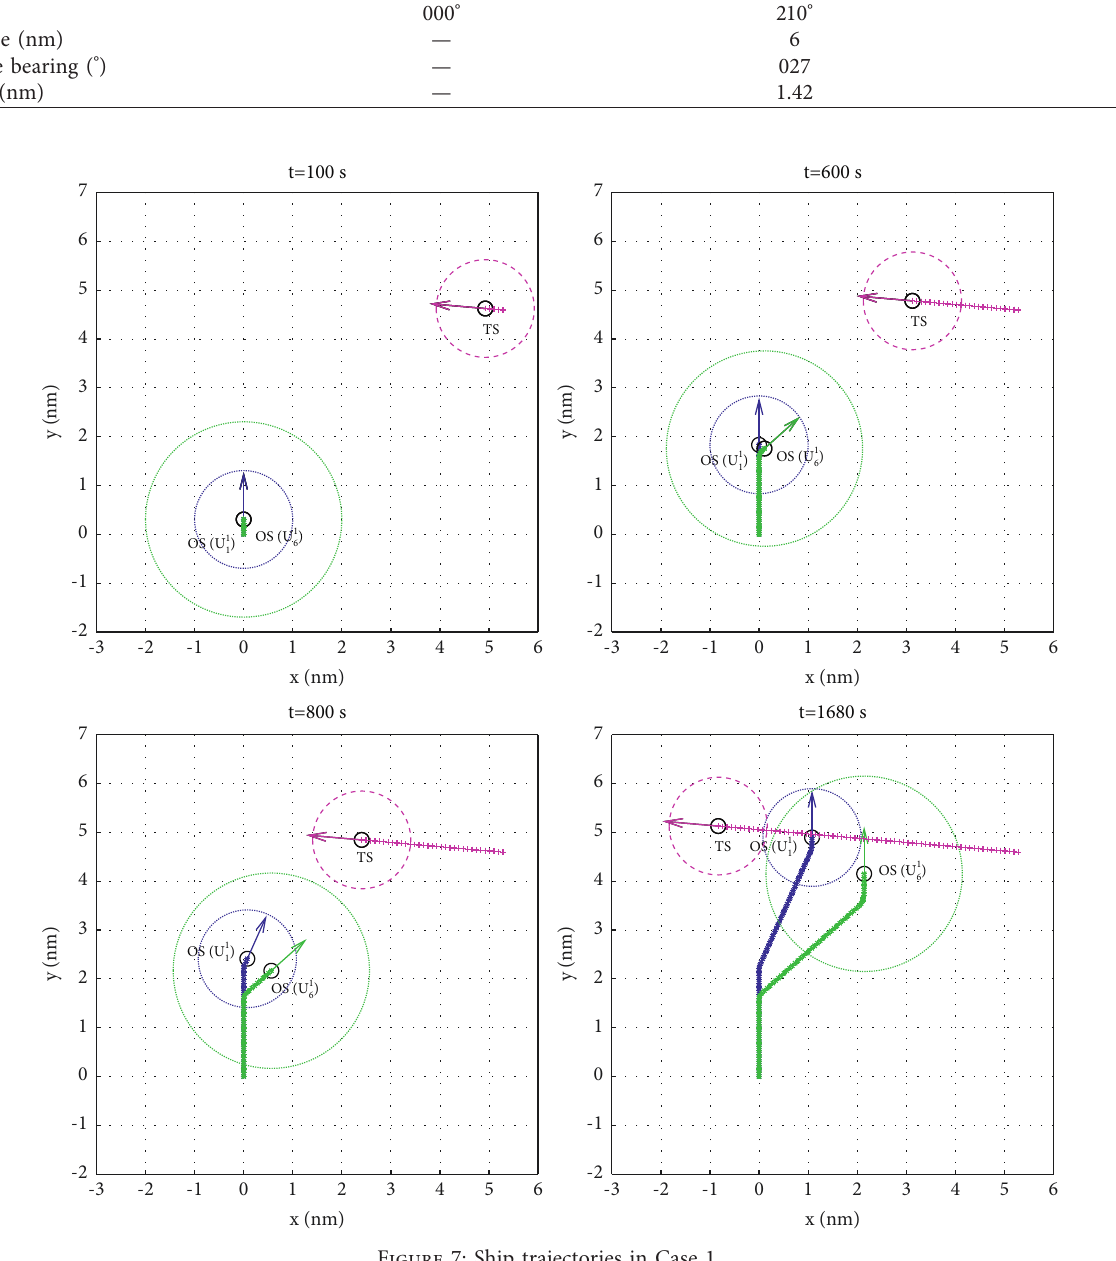
Figure 7: Ship trajectories in Case